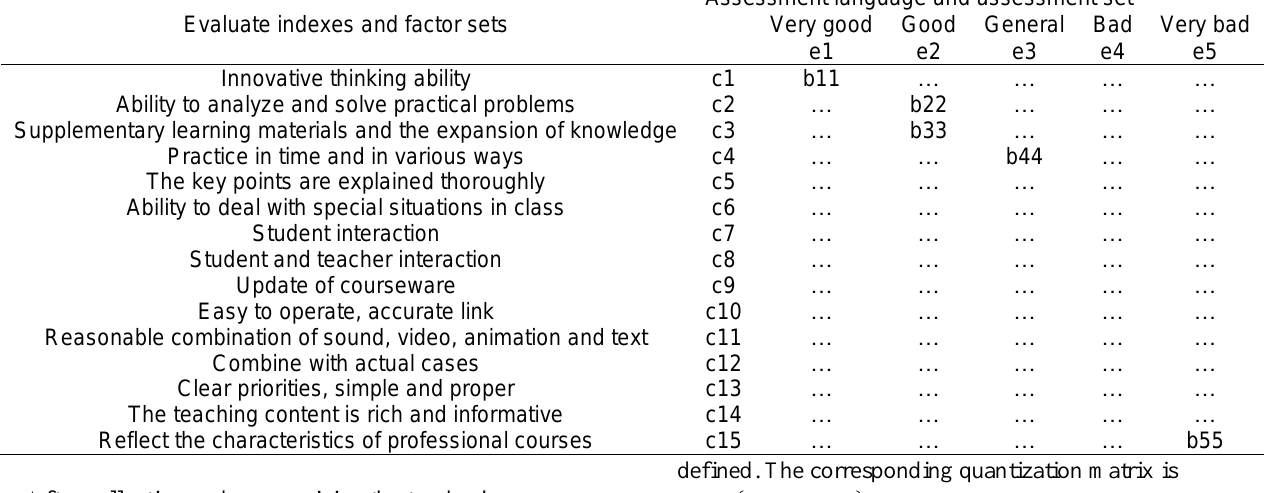
Evaluate indexes and factor